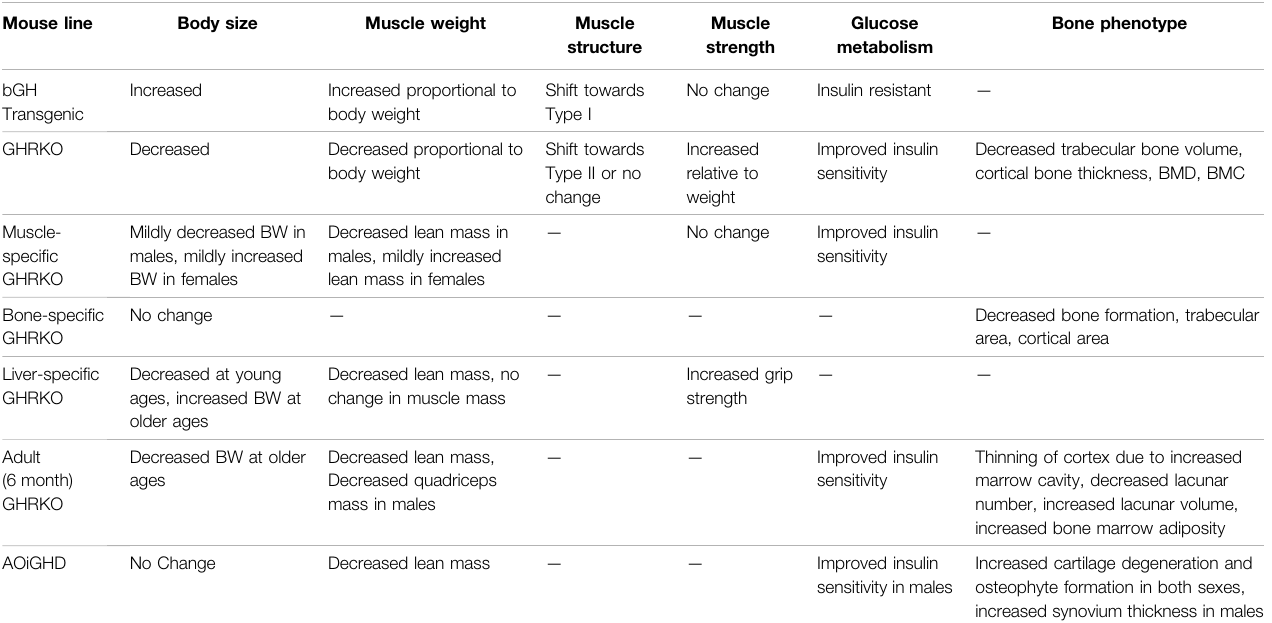
TABLE 1 | Summary of the musculoskeletal phenotypes of mouse models with altered GH action. Mouse